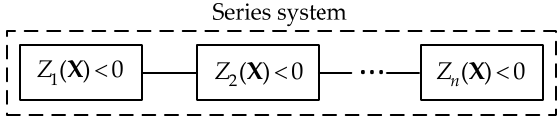
Figure 2. Multiple ‐ component series system. Figure 2. Multiple-component series